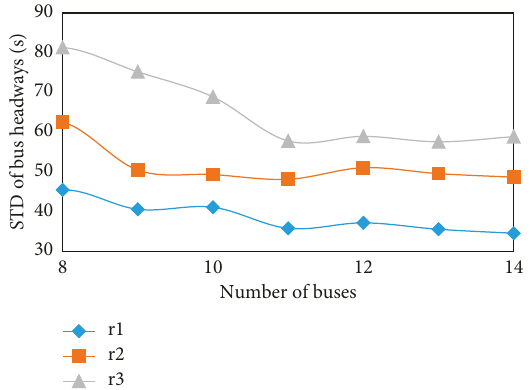
Figure 8: STD of bus headways with increasing buses on the route.